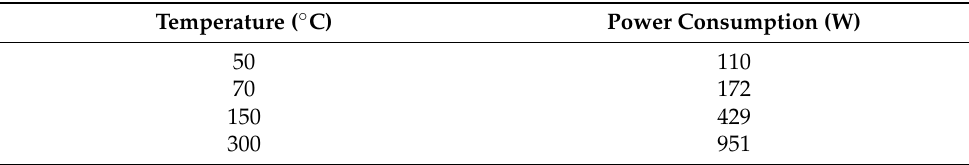
Table 3. Power consumption of the Binder FD-35